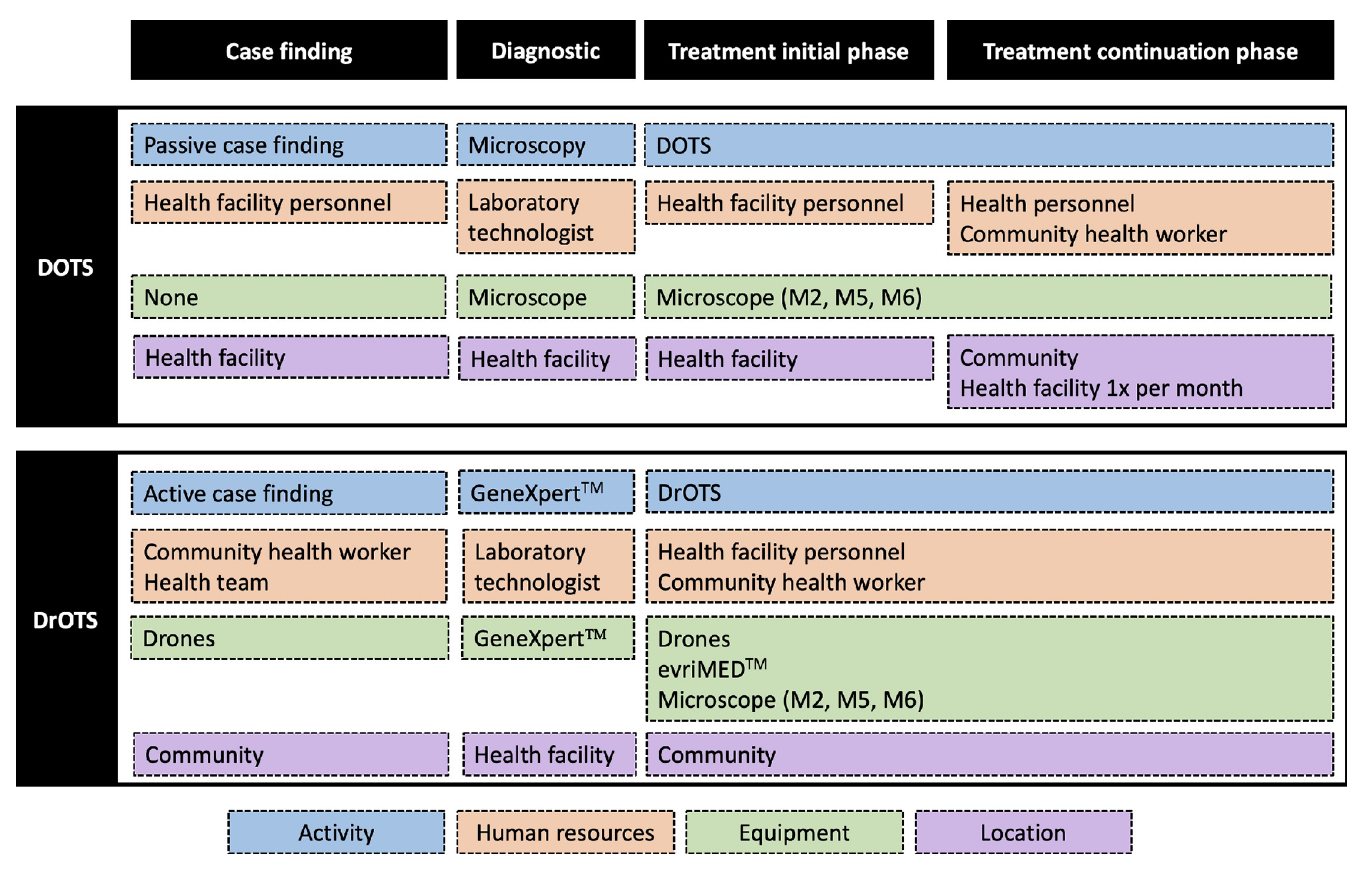
Fig 1. Modeled TB care strategies. DOTS; Directly Observed Therapy, DrOTS; Drone Observed Therapy System, GeneXpert ™ ; GeneXpert ™ MTB/RIF TB molecular testing platform, evriMED ™ ; Digital adherence monitoring technology.